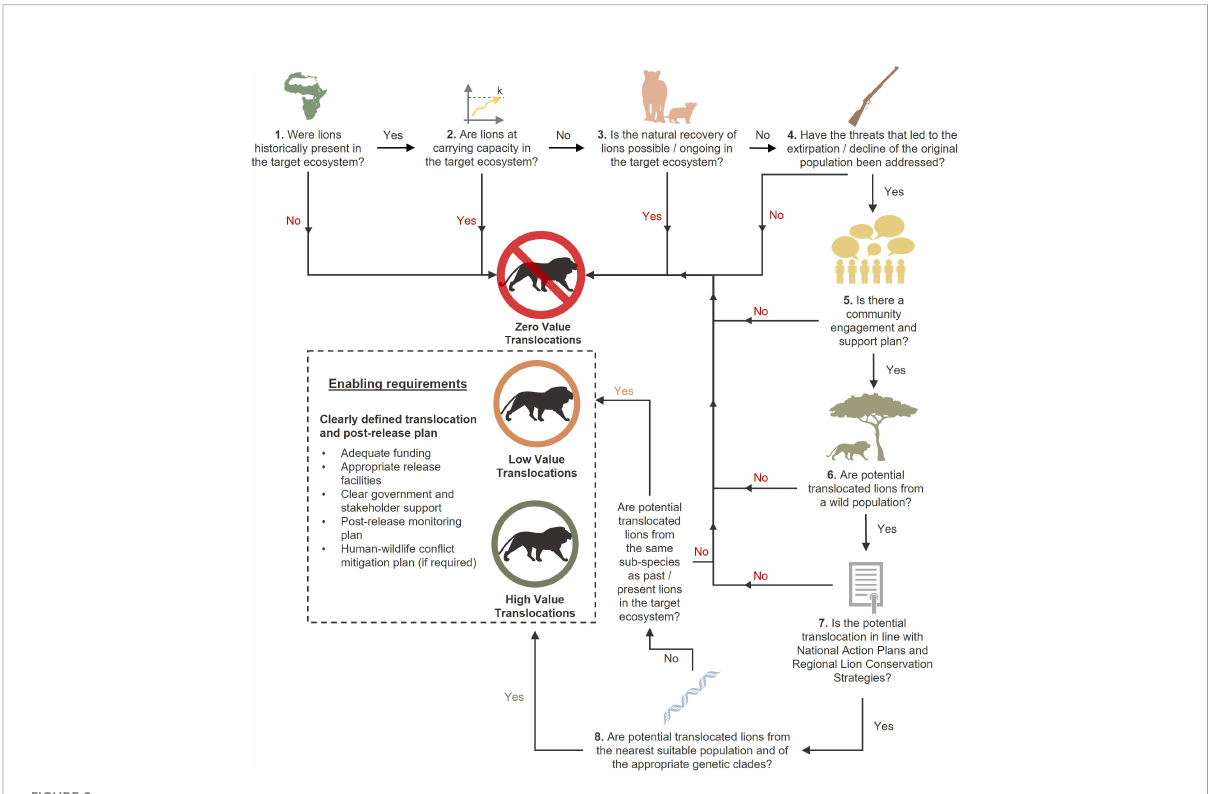
FIGURE 2 A decision tree for evaluating the conservation value of lion